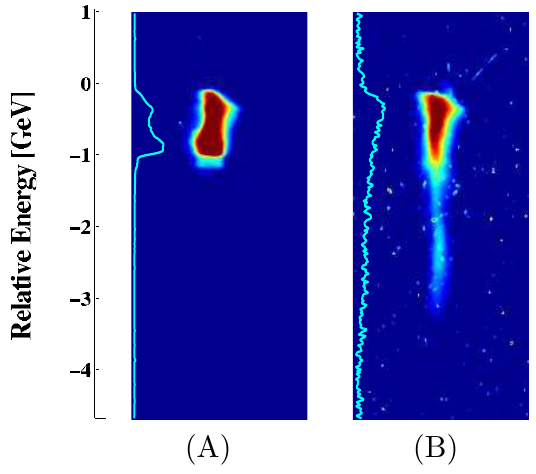
FIG. 7. (Color) Both images show the energy spectrum of the electron beam at the Cherenkov radiator. (A) The bunch is approximately 60 (cid:2) m long and no ionization has occurred in the Xe gas. (B) The bunch is approximately 20 (cid:2) m long and ionizes the Xe gas.